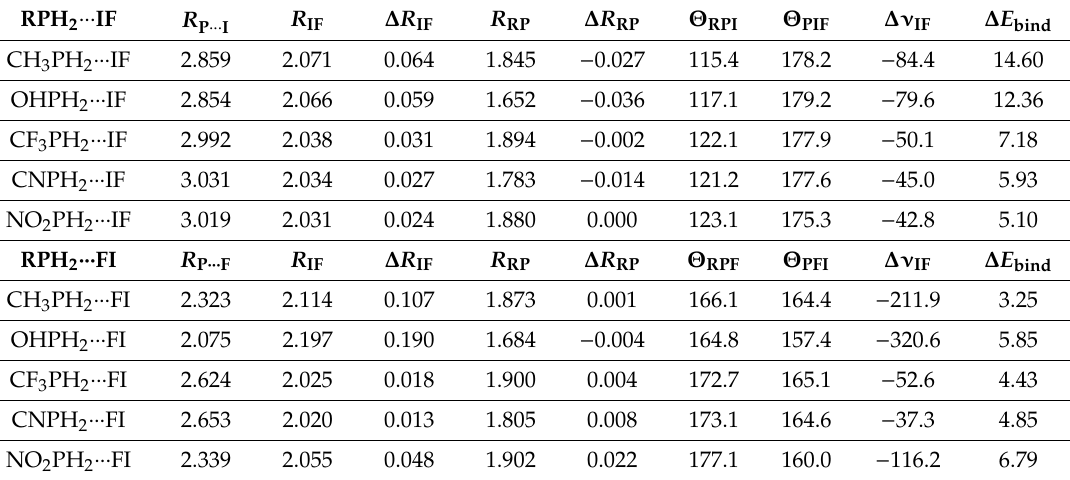
Table 1. Optimized dihalogen RPH 2 ··· IF and RPH 2 ··· FI complexes (B3LYP / mixed-PP level), showing key structural and energetic descriptors: Bond lengths ( R P ··· X , R IF , R RP ; Å) and changes from